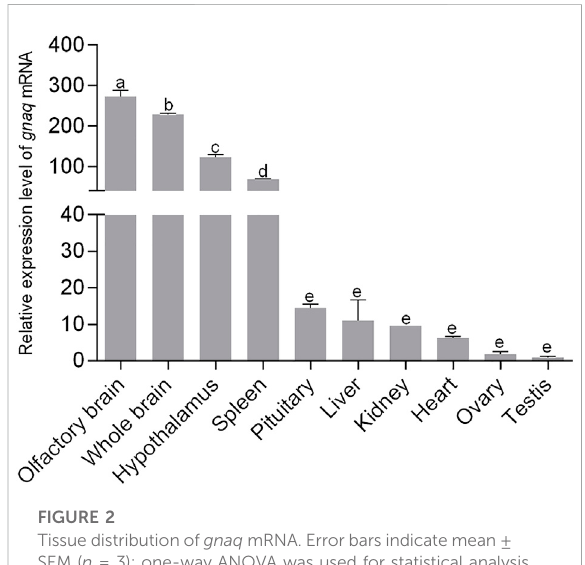
FIGURE 2 Tissue distribution of gnaq mRNA. Error bars indicate mean ± SEM ( n = 3); one-way ANOVA was used for statistical analysis ( p <